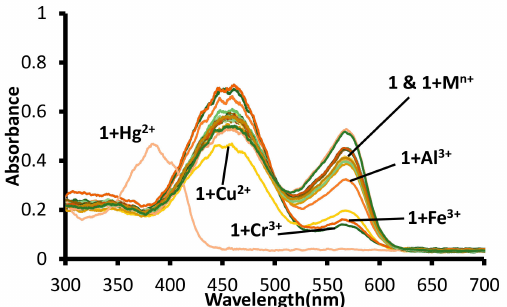
Figure 8. Change in absorption spectra of solutions of receptor 1 in water (pH = 7.6, 1.0 mM